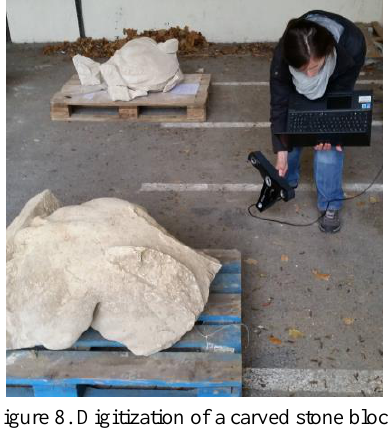
Figure 8. Digitization of a carved stone